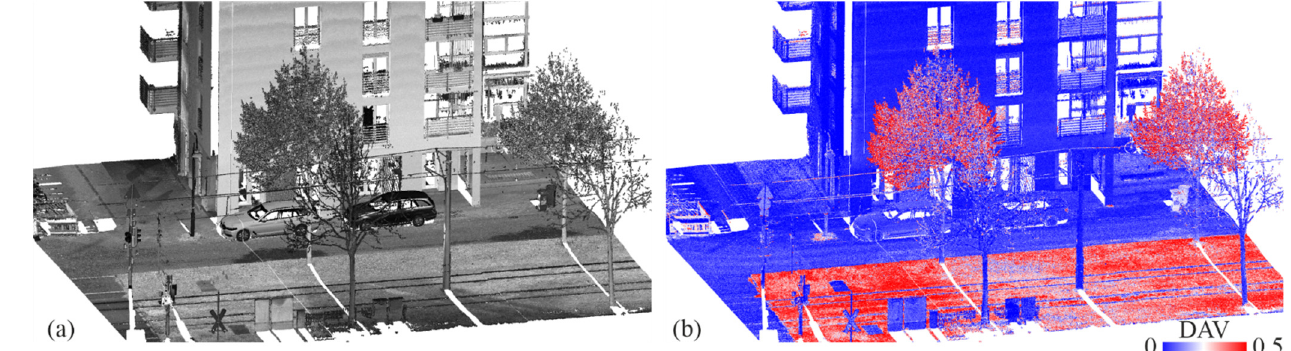
Figure 3. ( a ) Exemplary point cloud section in grayscale based on intensity return of the LiDAR system. ( b ) Same section but colored using the DAV with values going from blue for values around 0.0 over white to red for values around 0.5.